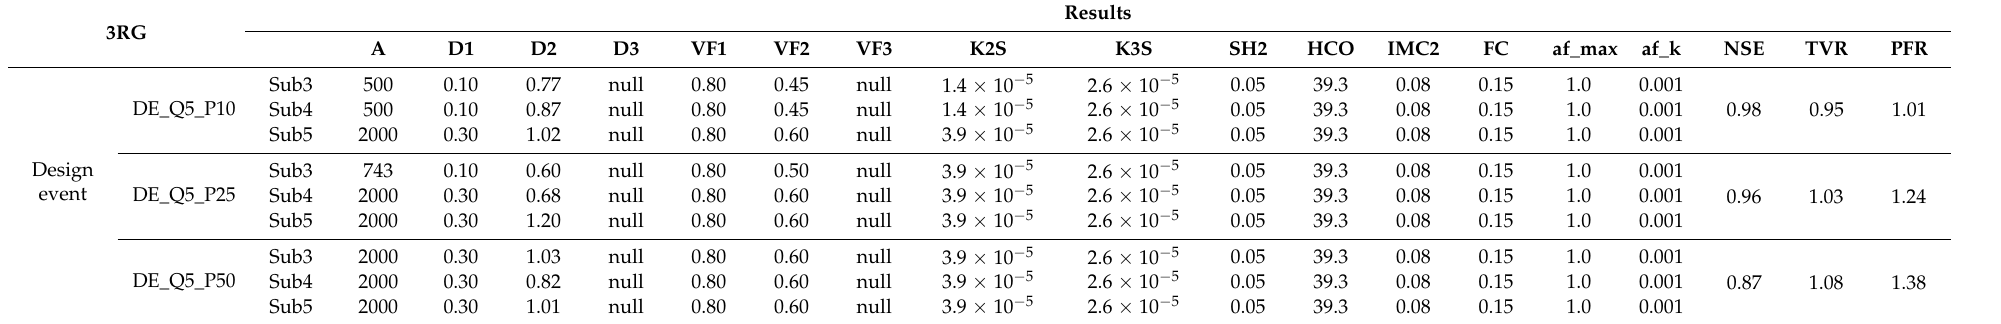
Table A5. The results of the 3RG scenario, which includes three types of a rain garden.